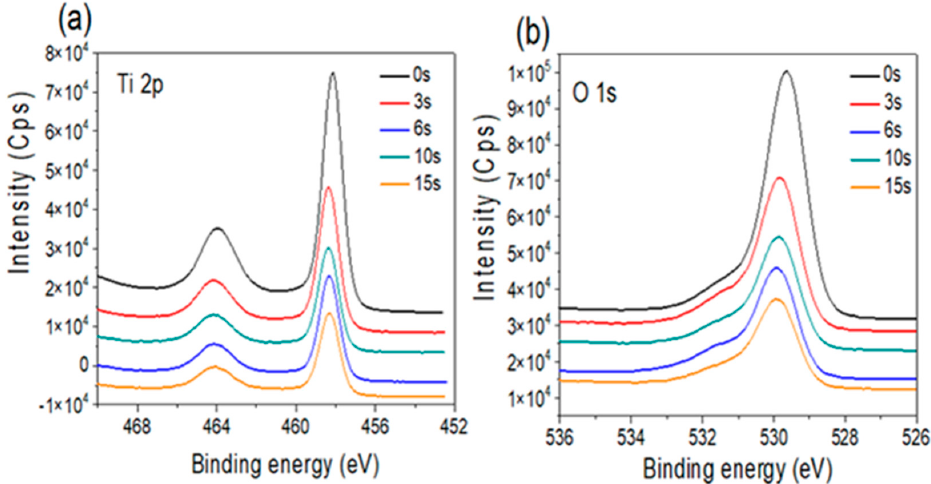
Figure 5. X ‐ ray photoelectron spectroscope data for the amorphous titania film after Au NP depo ‐ sition for 0 to 15 min: ( a ) Ti 2p core level spectra, and ( b ) O 1s core level spectra. for 0 to 15 min: ( a ) Ti 2p core level spectra, and ( b ) O 1s core level